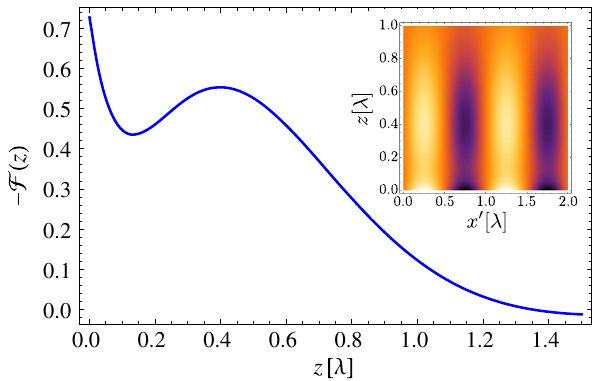
FIG. 7. The dimensionless function F ð z Þ determines the decay of the electrical potential away from the surface into the bulk; the characterisitc length scale is approximately set by the SAW wavelength λ ¼ 2 π =k ≈ 1 μ m. Inset: Density plot of the (nor- malized) electric potential Re ½ ϕ (cid:2) = ϕ 0 ¼ − F ð kz Þ sin ð kx 0 − ω t Þ along ˆ x 0 ∥ ½ 110 (cid:2) for a Rayleigh surface acoustic wave propagating on a (001) GaAs crystal at t ¼ 0